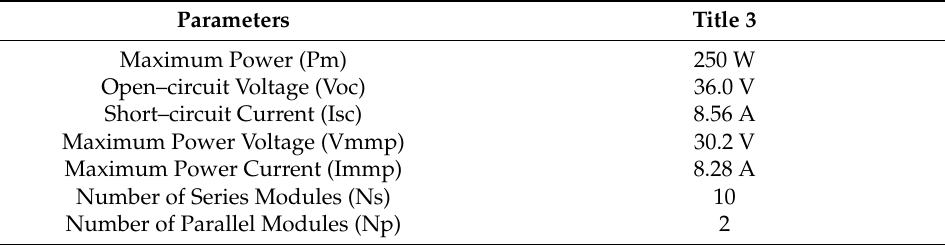
Figure 2. The schematic diagram of proposed PV system. Table 1. UP-S250 PV module electrical parameters.